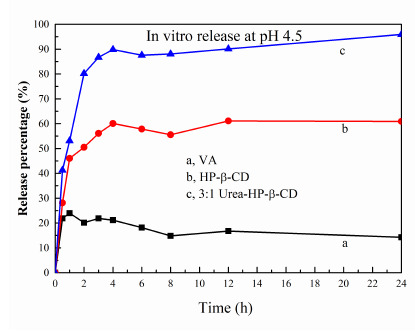
Fig. 8. VA Release profiles (a) VA (b) HP- β